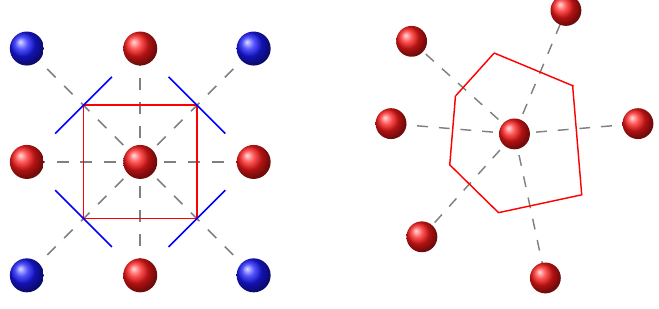
Figure 2. Visualization of the next neighbor generation in a cubic lattice (left) and a Voronoi set (right). For most physical processes, only the nearest-neighbors, highlighted in red color, are considered. The blue lattice sites do not define the Voronoi cell; thus, they are not labeled as next